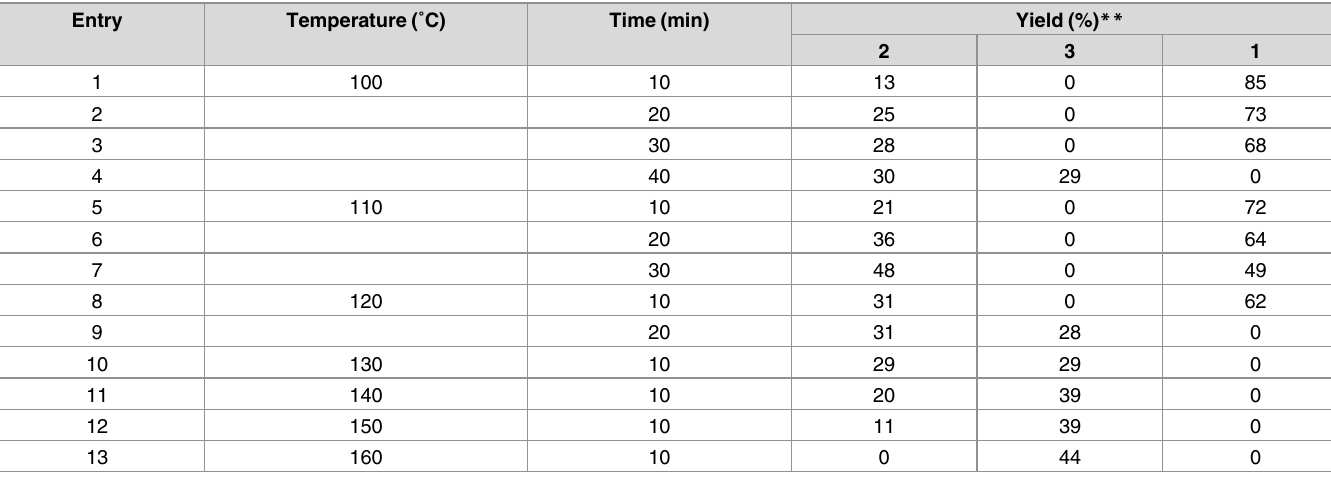
Table 1. Optimization of reaction temperature and time. *